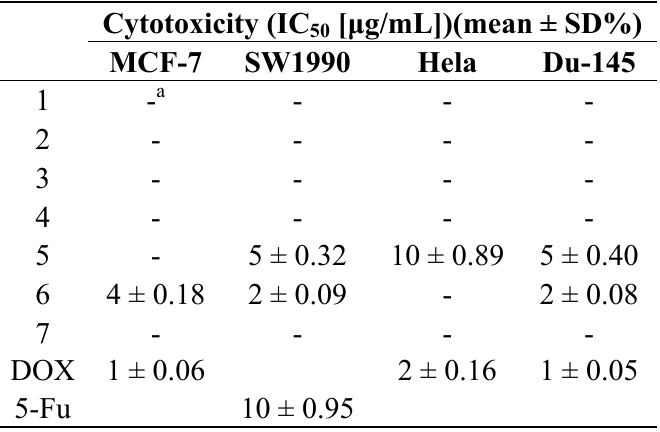
Table 2. Cytotoxicity of 1 – 7 against four cancer cell